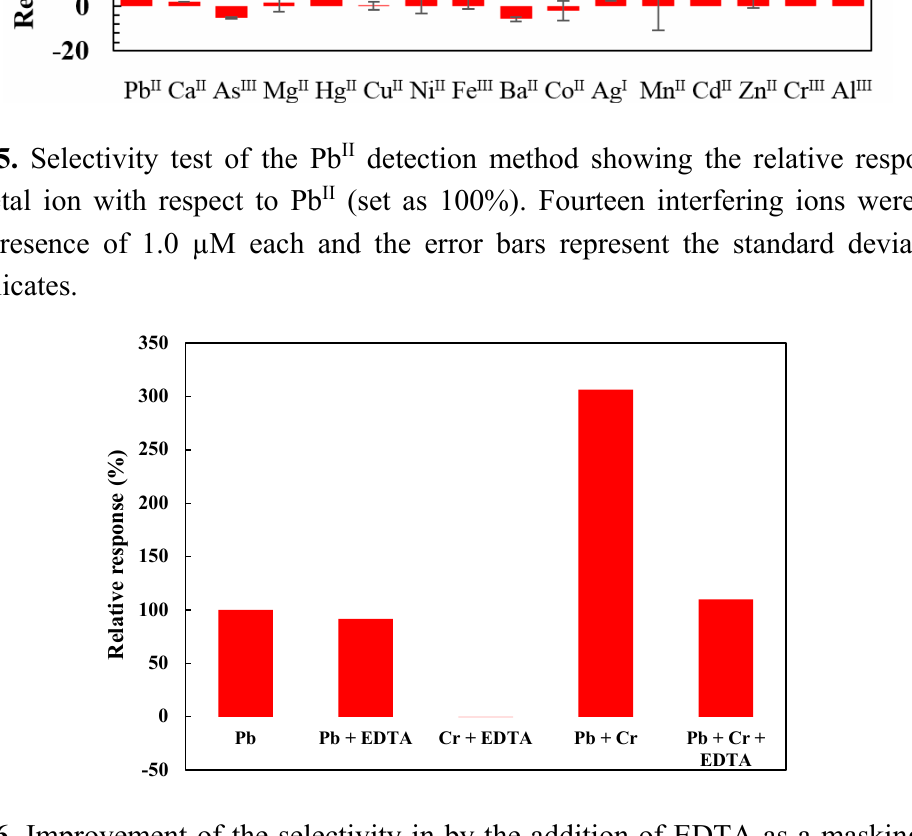
Figure 6. Improvement of the selectivity in by the addition of EDTA as a masking agent (Pb II was at 1 µM, Cr III 4 µM and EDTA 1